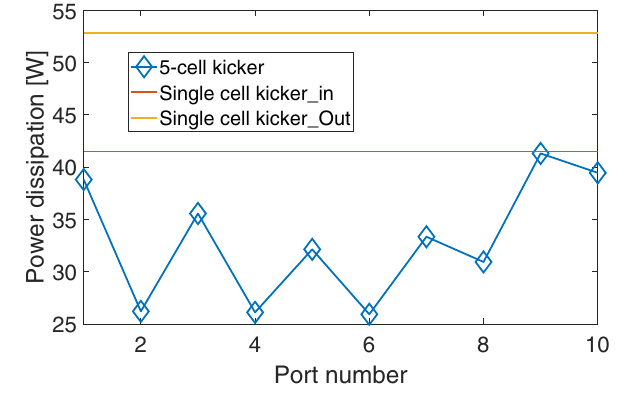
FIG. 5. The blue curve represents the beam power transport through different feedthrough ports of the five-cell kicker. The orange and yellow curves represent that transport through the input and output ports of the single cell